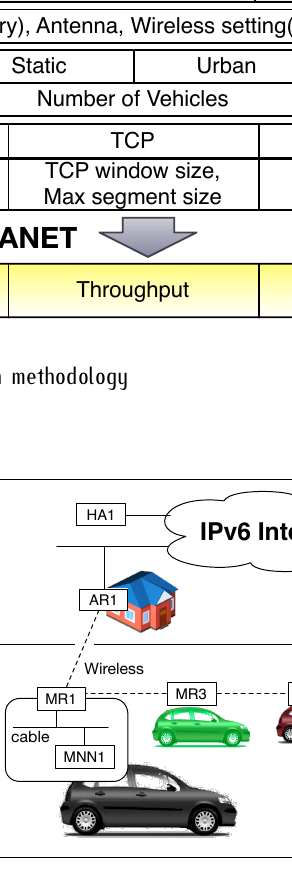
Figure 4. Reference network